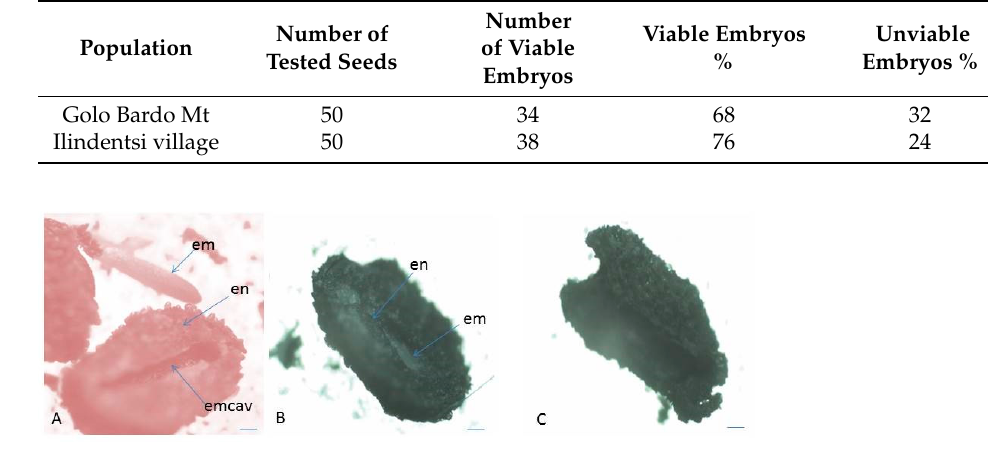
Figure 6. Assessment of seed (embryo) viability in P. veris after TZ testing. ( A ) Seed with endosperm and viable embryo, ( B ) seed with endosperm and unviable embryo, ( C ) empty seed (without embryo) unnviable. em—embryo; en—endosperm; emcav—ES cavity. Scale bar = 100 μ m.